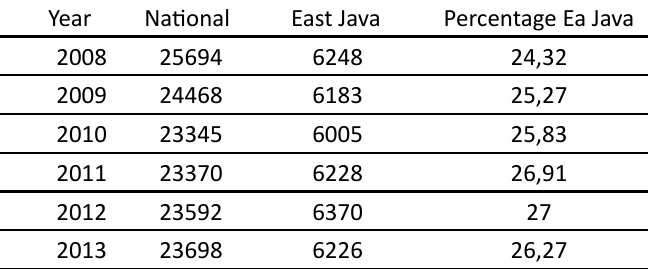
Table 1: Survey Distribution of Manufacturing Year National East Java Percentage Ea Java 25694